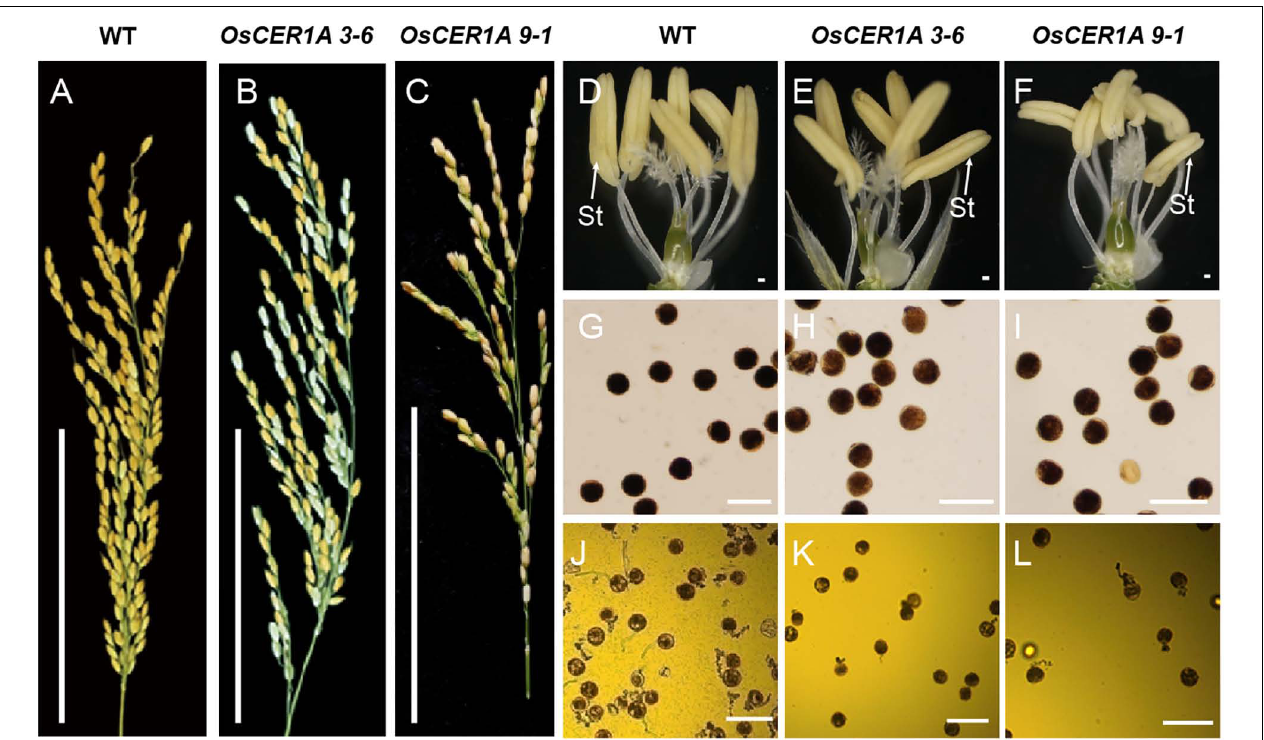
FIGURE 3 | Comparison of the WT plants and OsCER1A lines. (A–C) Comparison of seed setting rate between the WT (A) , OsCER1A 3-6 (B) , and OsCER1A 9-1 (C) plants showing low seed setting rate in the OsCER1A plants. (D–F) A WT spikelet (D) , an OsCER1A 3-6 spikelet (E) , and an OsCER1A 9-1 spikelet (F) after removing the lemma and palea showing no obvious difference in stamens with each other. (G) Mature pollen grains stained with 1% I 2 /KI solution in the WT plants. (H,I) Abnormal pollen grains stained with 1% I 2 /KI solution in the OsCER1A 3-6 (H) and OsCER1A 9-1 (I) plants showing lightly stained pollen grains. (J–L) In vitro pollen germination of the WT (J) , OsCER1A 3-6 (K) and OsCER1A 9-1 (L) plants. St, stamen. Bars = 10 cm in (A–C) ; 100 µ m in (D–F) ; 50 µ m in (G–L)